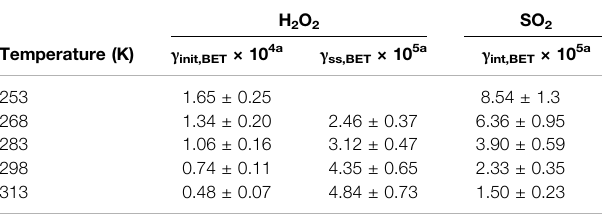
TABLE 1 | Summary of the uptake coef fi cients of H 2 O 2 and SO 2 on coal fl y ash at different